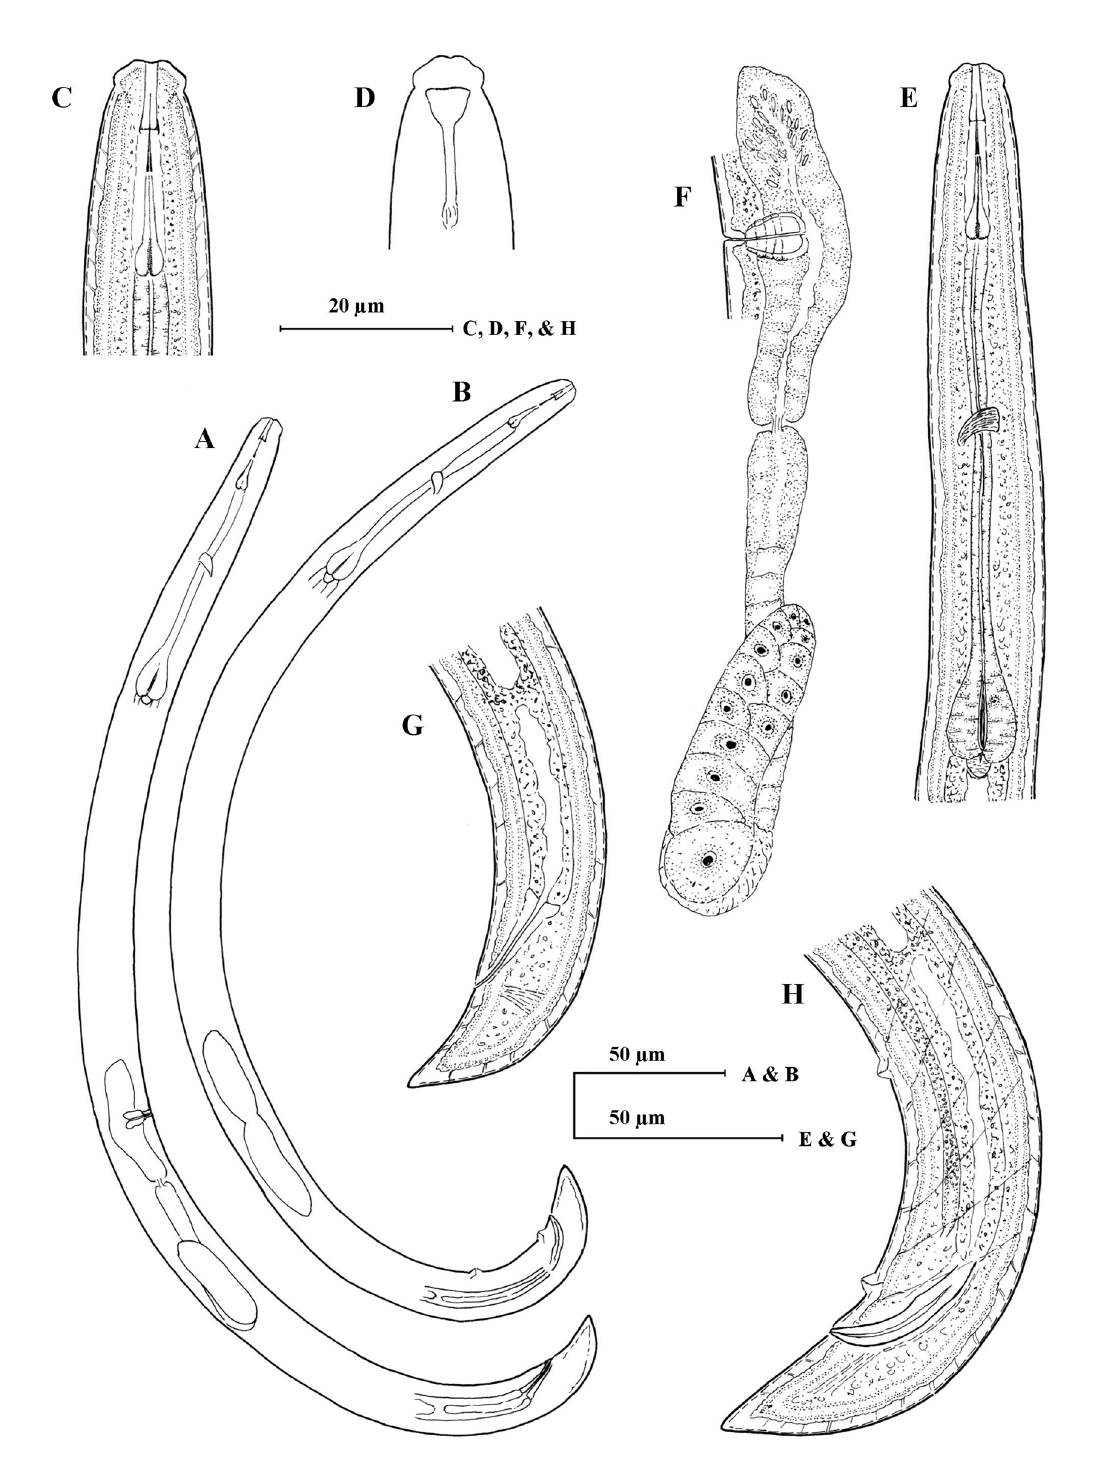
Fig. 8. Basirotyleptus conicaudatus sp. nov. A, C–G . Holotype, ♀ (AMU/ZD/NC/ Basirotyleptus conicaudatus /1). B, H . Paratype, ♂ ( AMU/ZD/NC/ Basirotyleptus conicaudatus /2). A . Entire female. B . Entire male. C . Female, anterior region. D . Female, anterior region showing amphid. E . Female, pharyngeal region. F . Female, genital system. G . Female, posterior region. H . Male, posterior